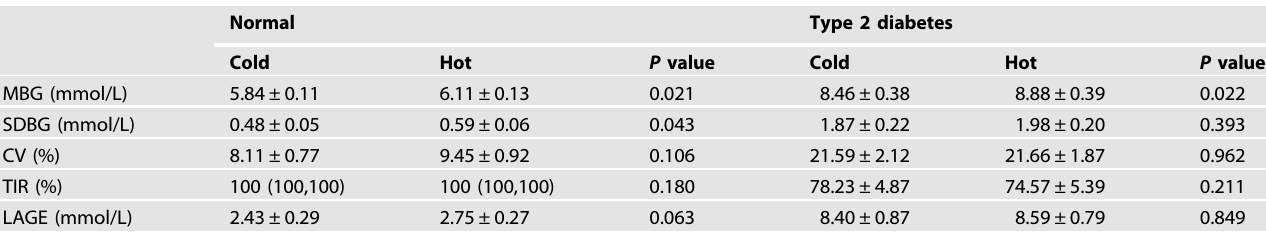
Table 3. Glycemic variability in CGM during hot and cold food intake